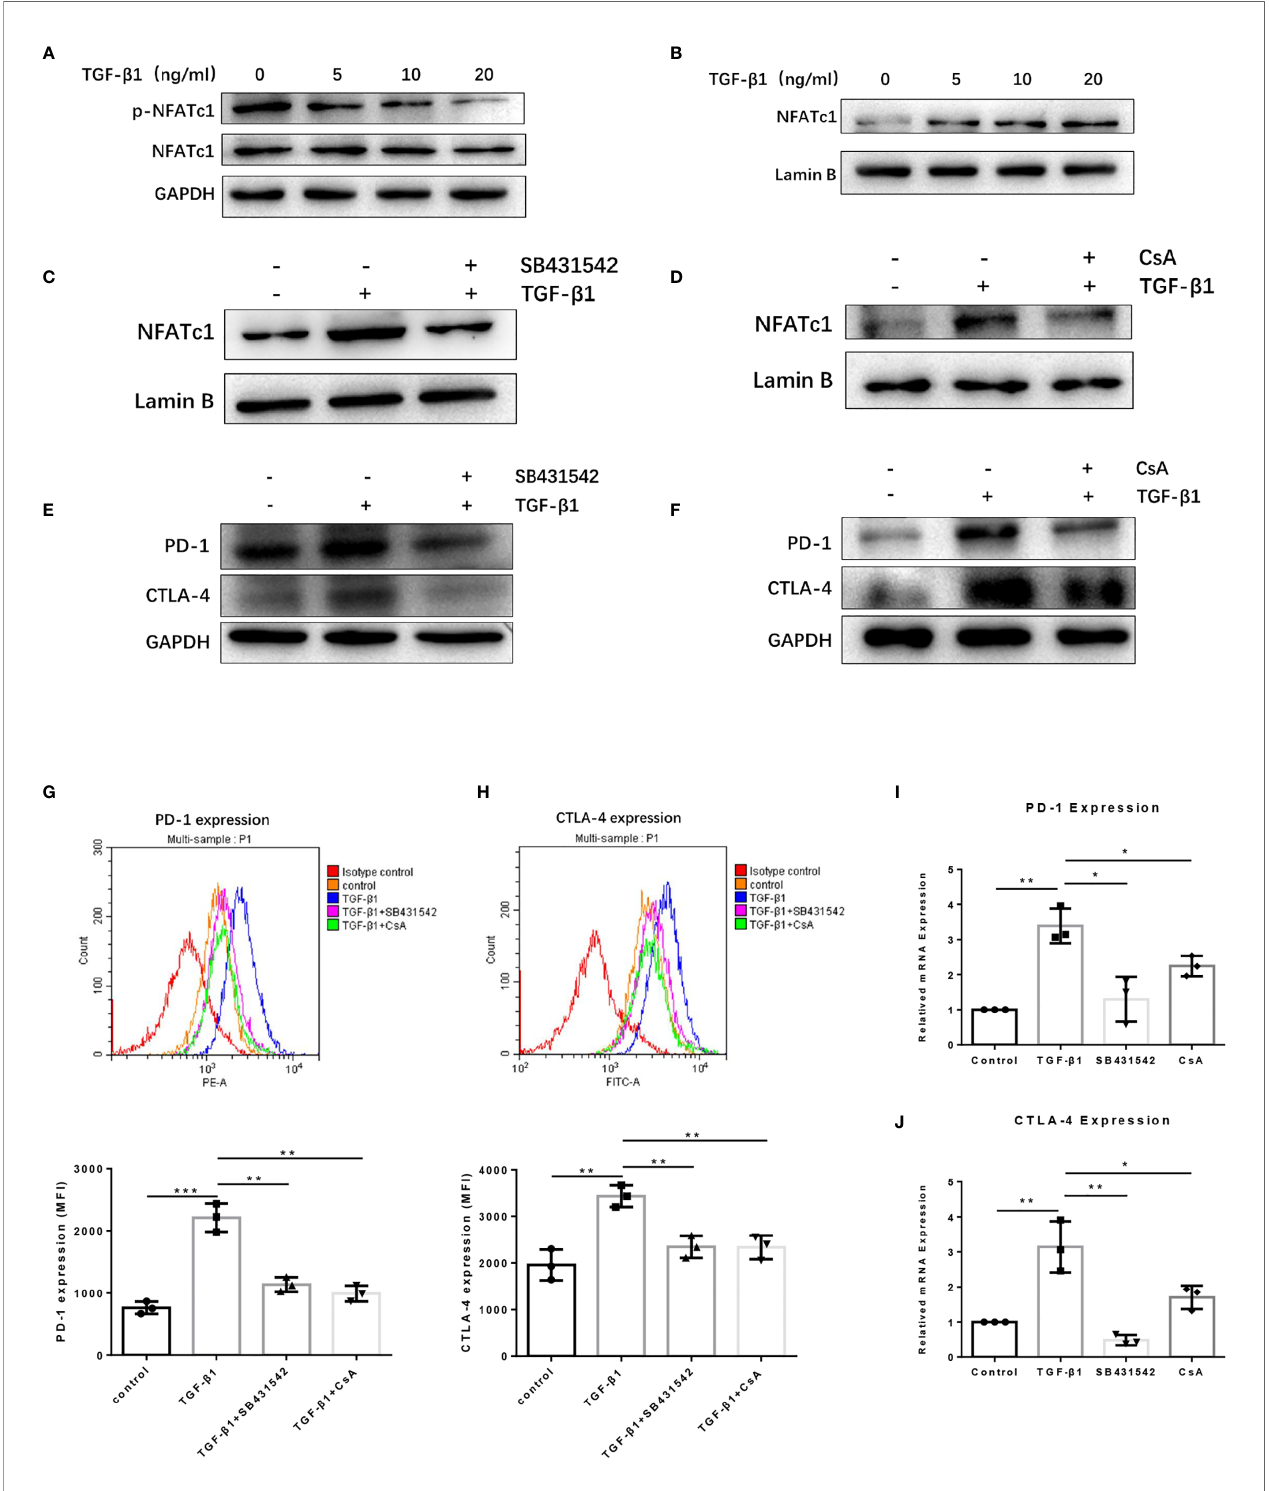
FIGURE 5 | TGF- b 1 promotes the expression of PD-1 and CTLA-4 on T cells via TGF b R/CaN/NFATc1 signals. (A) Western blot was used to detect the expression of total NFATc1 protein and phosphorylated NFATc1 protein in T cells. (B – D) Western blot was used to detect the expression of NFATc1 protein in the nucleus of T cells. (E, F) Western blot was used to detect the protein expression of PD-1 and CTLA-4 in T cells. (G) Flow cytometry was used to detect the expression of PD-1 on T cells. (H) Flow cytometry was used to detect the expression of CTLA-4 on T cells. (I) qPCR was used to detect the mRNA level of PD-1 in T cells. (J) qPCR was used to detect the mRNA level of CTLA-4 in T cells. n = 3, *P < 0.05, **P < 0.01, ***P < 0.001 vs. control